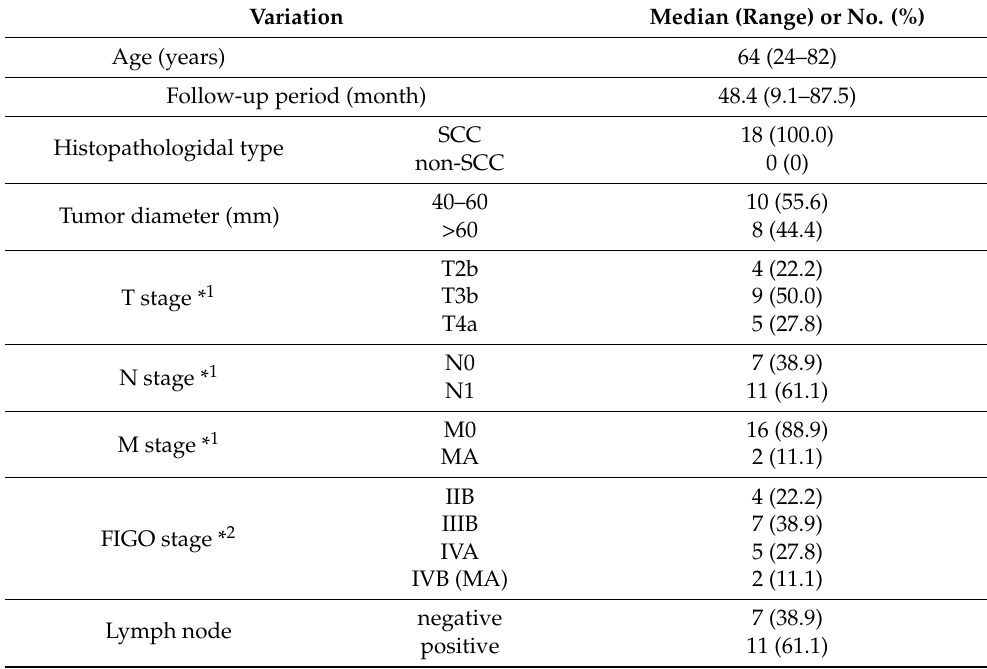
Figure 1. Flow diagram of participants with detailed information on excluded patients. Table 1. Patient characteristics ( n = 18)